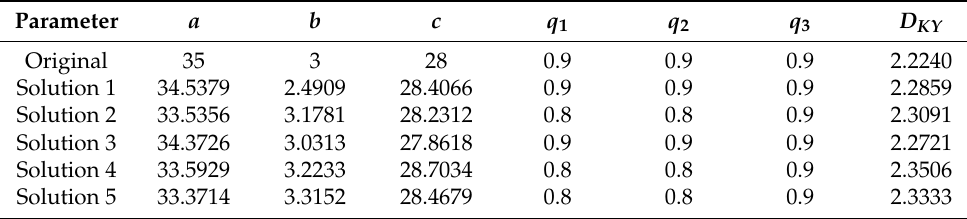
Table 1. Five solutions of the optimization of Chen system (3) applying